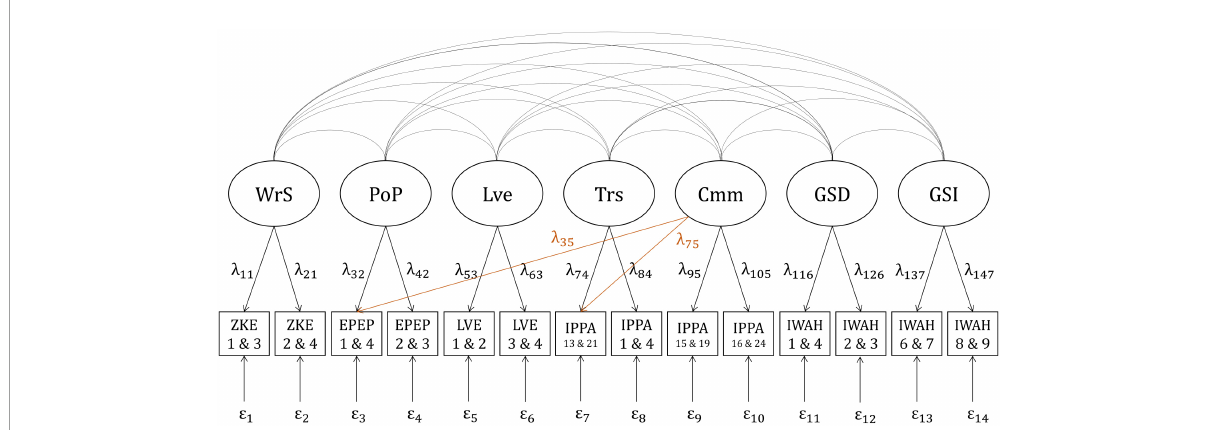
FIGURE3 Adjusted positive correlation model for the German and the English sample. WrS, Warmth/Support; PoP, positive parenting; Lve, love; Trs, trust; Cmm, communication; GSD, global self-definition; GSI, global self-investment; ZKE, “Zürcher Kurzfragebogen zum Erziehungsverhalten”; EPEP, “Evaluation des Pratiques Educatives Parentales”; LVE, items measuring parental love; IPPA, “Inventory of Parent and Peer Attachment”; IWAH, “Identification With All Humanity scale”. Latent factors (e.g., WrS) are displayed in circles. Indicators (e.g., ZKE 1 and 3) are displayed in squares. Numbers beneath the abbreviations of questionnaires indicate item numbers of the items forming particular indicators (e.g., Item 1 and item 3 from the ZKE form one indicator displayed as ZKE 1 and 3). Curved lines indicate correlations between latent factors. Arrows with factor loadings (e.g., λ 11 ) illustrate the assumption that the indicators are predicted by specific latent factors. Residual variances are displayed below the indicators (e.g., ε 1 ). One modification of the original positive model ( Figure 1 ) was made to improve model fit: the factor “communication” was allowed to additionally load on the indicators “IPPA 13 and 21” and “EPEP 1 and 4.” This change is marked in orange.